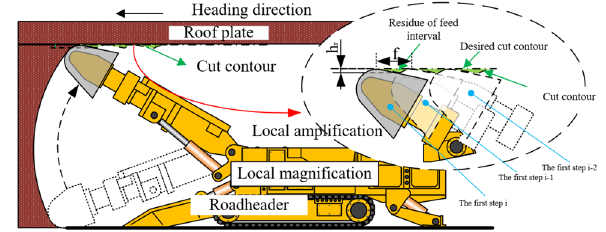
Figure 1. Schematic diagram of roof forming process of driving